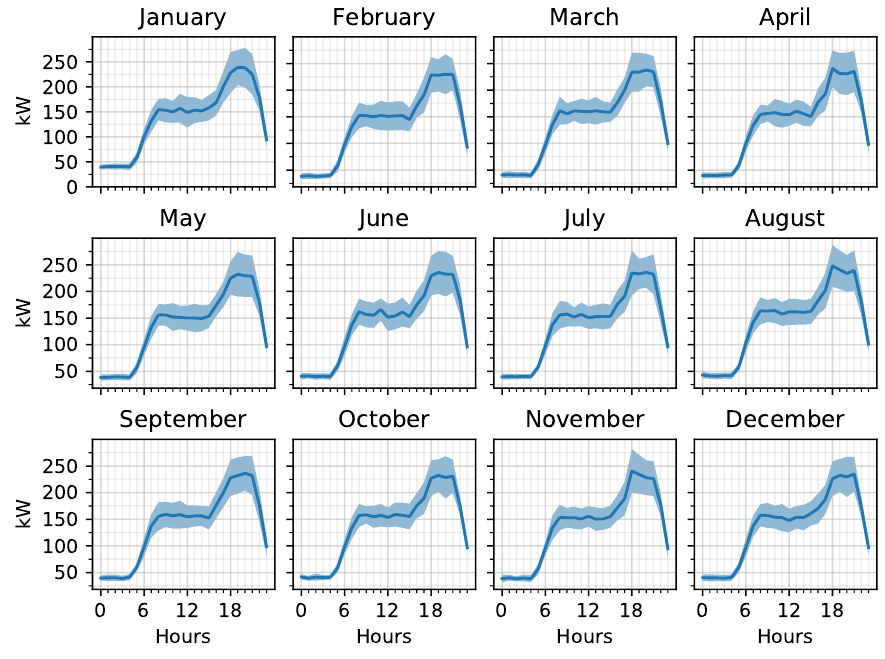
Figure 3. Fitting of the electrical